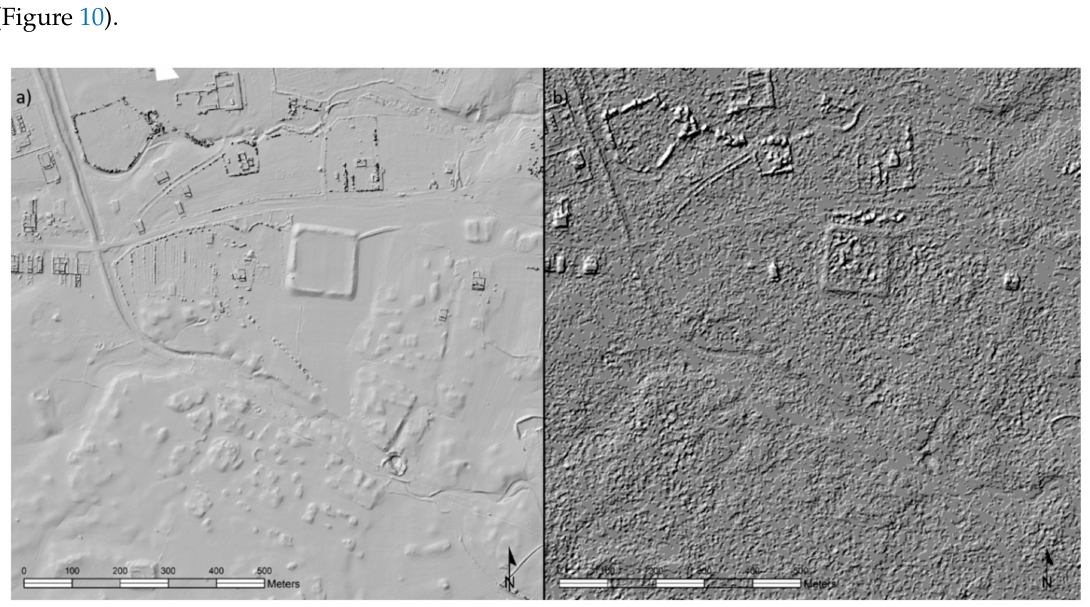
Figure 10. The comparison of the digital elevation models (DEMs) created on the basis of UAV images and on the basis of the stereo pair of satellite images: ( a ) DEM created from the photographic dataset, taken by UAV; maximal resolution 20 cm (data obtained through the Czech Technical University in Prague); ( b ) DEM created from the stereo pair of the Pleiades-2 system; maximal resolution 1.6 m (authors: Jaroslav Šedina, Karel Pavelka and Lenka Starkov á